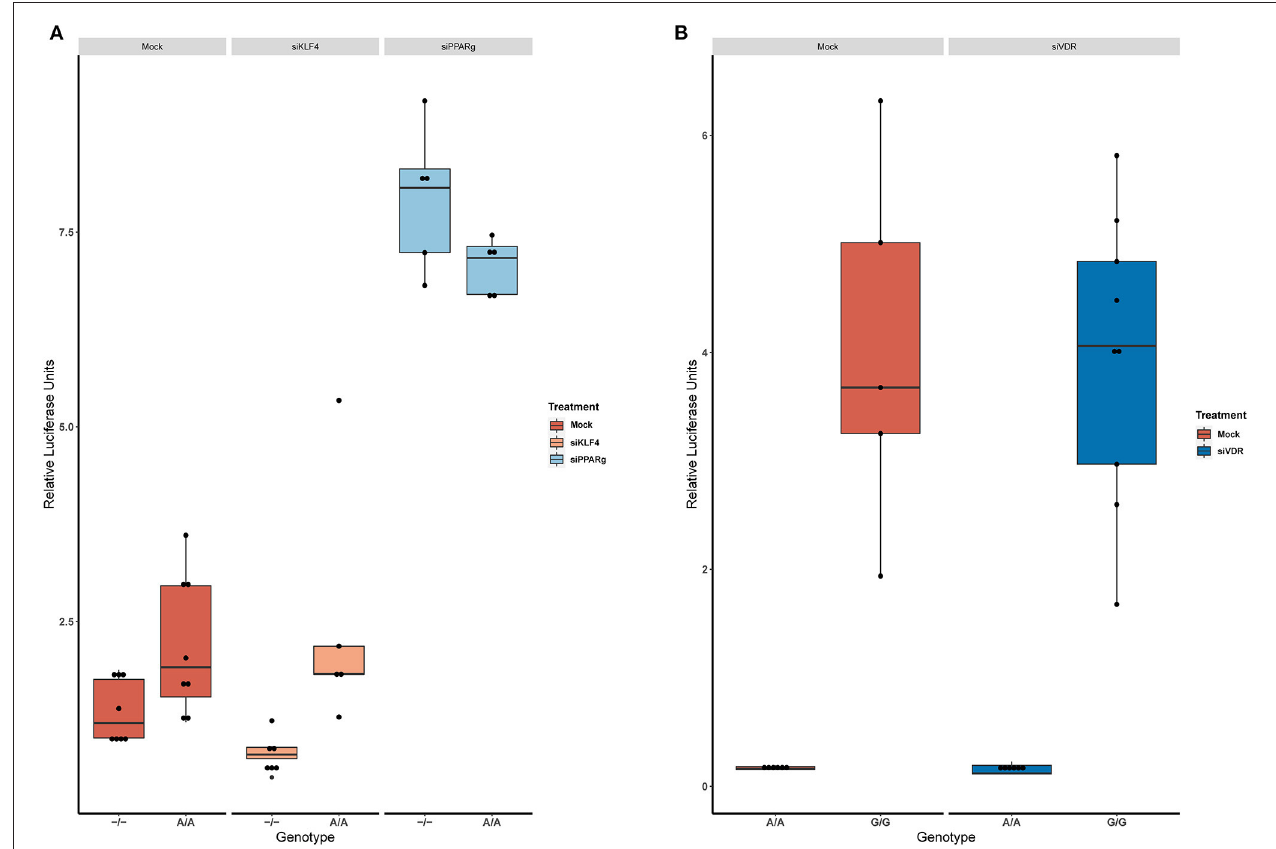
FIGURE 4 | KD experiments demonstrate that PPAR γ binds in rs397751713. (A) Comparison of the luciferase activity in the homozygous genotypes of rs397751713 after different treatments, siKLF4 and Mock show the same pattern while siPPAR γ increases the activity of both genotypes to similar levels ( n = 3). (B) Comparison of the luciferase activity in the homozygous genotypes of rs2859338 after Mock or siVDR treatment shows the same pattern. Data are shown as box plots representing median ± quartiles. Dots represent biological replicates. PPAR γ , peroxisome proliferator-activated receptor γ .